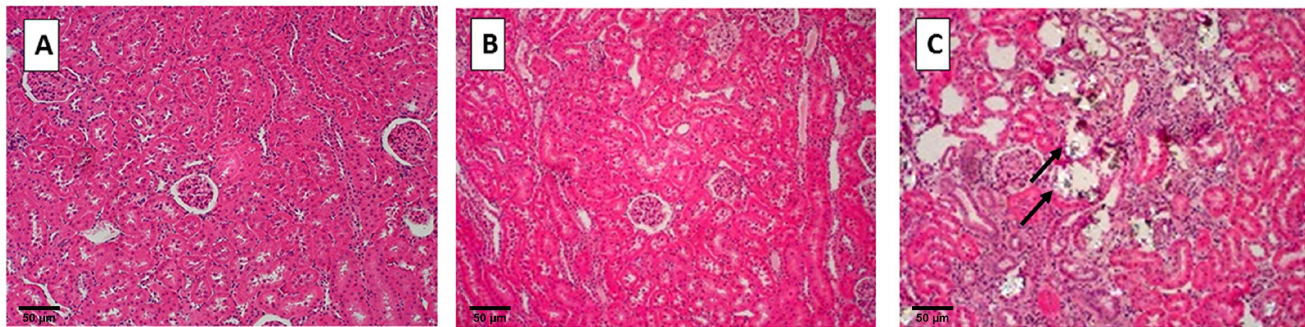
Fig 2. Hematoxylin and eosin staining of paraffin embedded kidneys examined under polarized light. A) Controlrats, no crystal deposition and B) rats fed 1.25% EthyleneGlycol (EG), observed on Day 14 (Hyperoxaluric stage) and C) rats fed 1.25% EG with lots of birefringent crystals observedon Day 28 (Nephrolithiasis stage), shown by black arrows Magnification 10x, Scale bar 50 μ m.